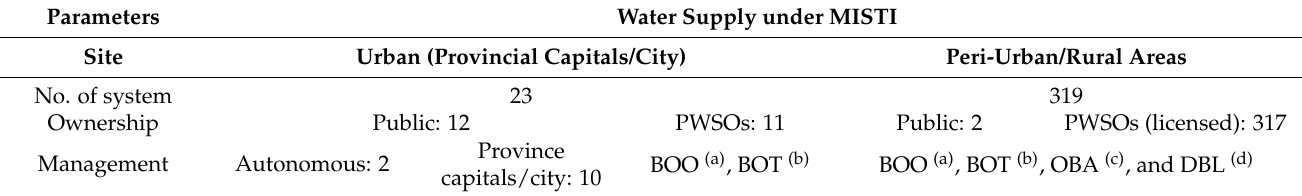
Table 1. Water supply under MISTI (29 April 2022).